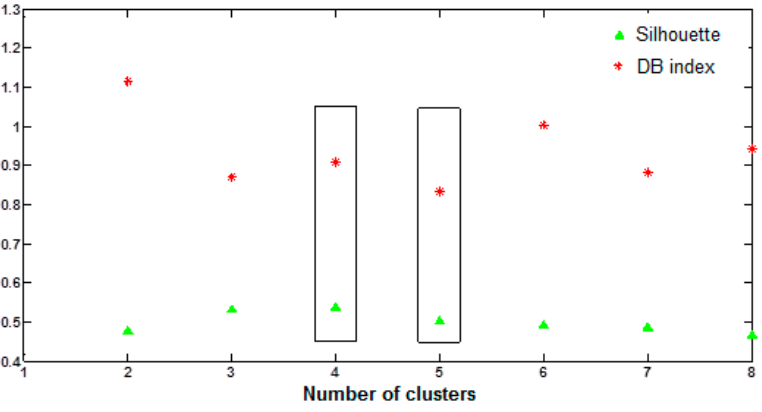
Figure 6. Silhouettes and Davis–Bouldin indices for different numbers of clusters.